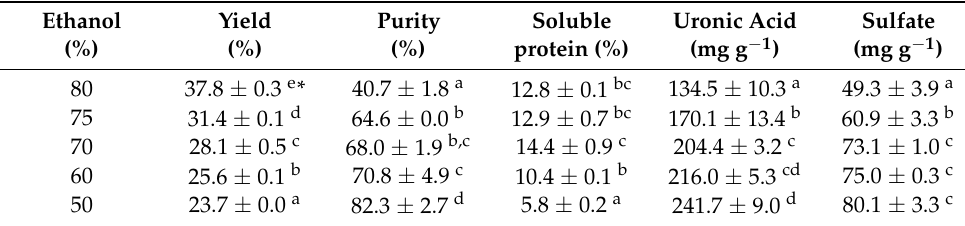
Table 4. The effect of different ethanol concentrations on the ChS yield and its quality (purity and contents of soluble protein, uronic acid, and